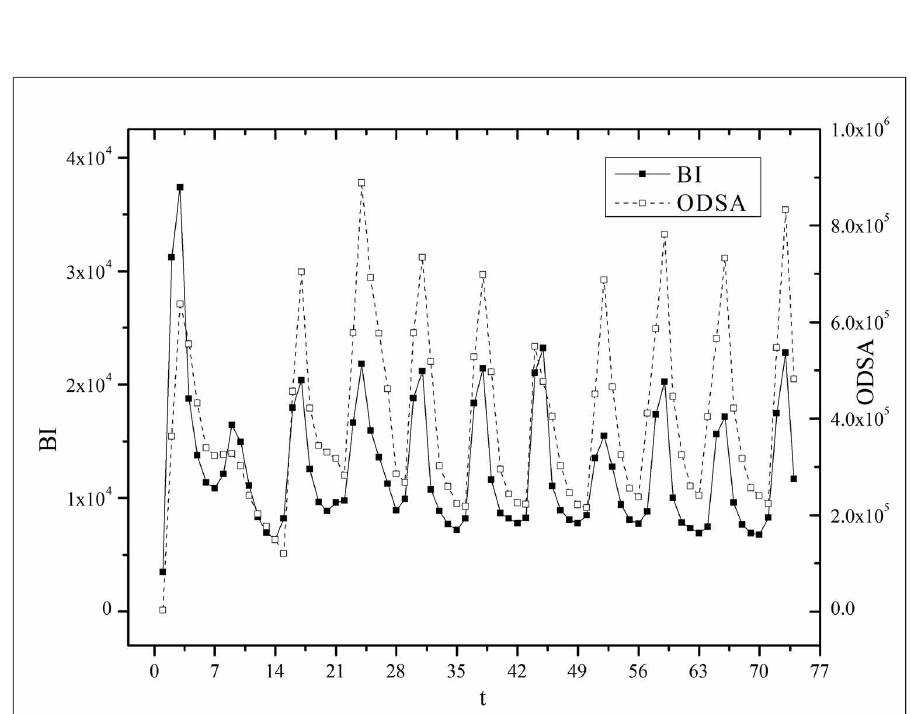
Fig 13. Correlation analysis of the Kaputori dataset.